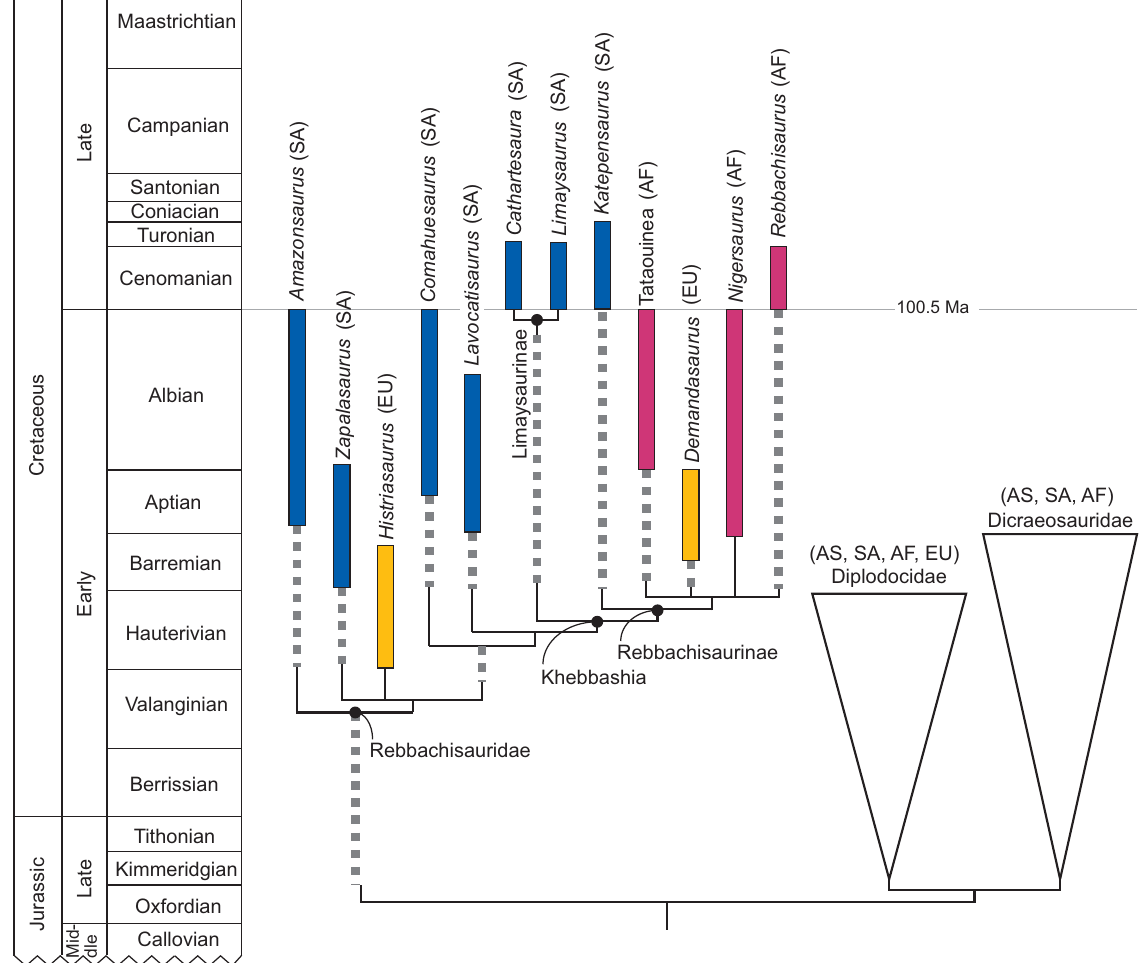
Fig. 5. Stratigraphically calibrated strict tree after pruning Lavocatisaurus , showing the geographical provenance of the taxa (silhouettes of continents) and ghost lineages (dashed lines). Abbreviations: AF, Africa, AS, Asia; EU, Europe; SA, South